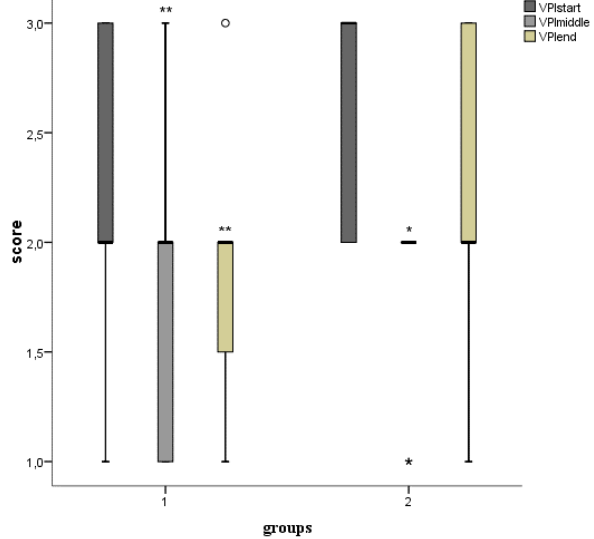
Figure 3. Boxplots for mean visible plaque index (VPI, scores 0 = no visible plaque3 = visible plaque on all tooth surfaces). Measuring points for group 1 (start = 0 days, middle = 14 days, end = 28 days) and group 2 (start = 0 days, middle = 7 days, end = 14 days). p < 0.001***, p < 0.01**, p < 0.05* (smaller asterisks). Decreases/increases of VPIs were compared pairwise: start/middle, start/end. Values more than three interquartile range (IQR) from the end of a box are labeled as extreme outliers (larger asterisks) and values more than 1.5 but less than 3 IQR’s from the end of a box are labeled (o) outliers.